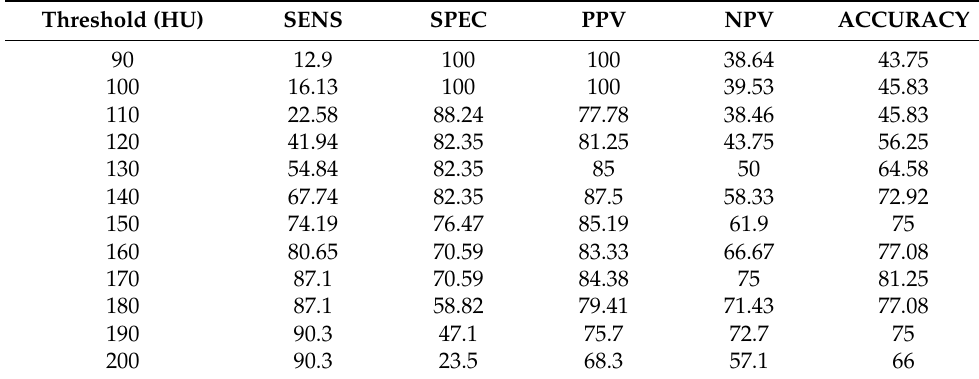
Table A3. Diagnostic performance at L1—low BMD (Osteopaenia and Osteoporosis).